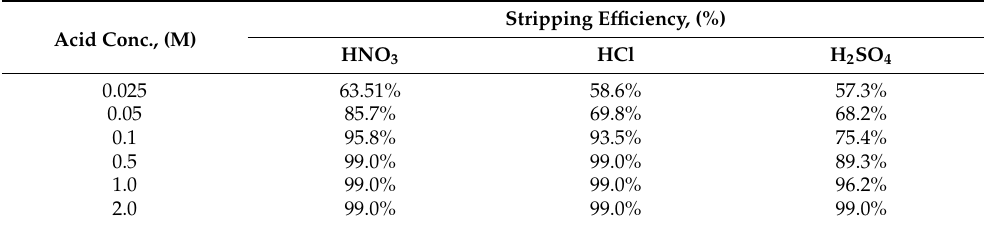
Table 5. Effect of stripping agent conc. on U(VI) ion elution from HTIP–U(VI) complex. Acid Conc.,